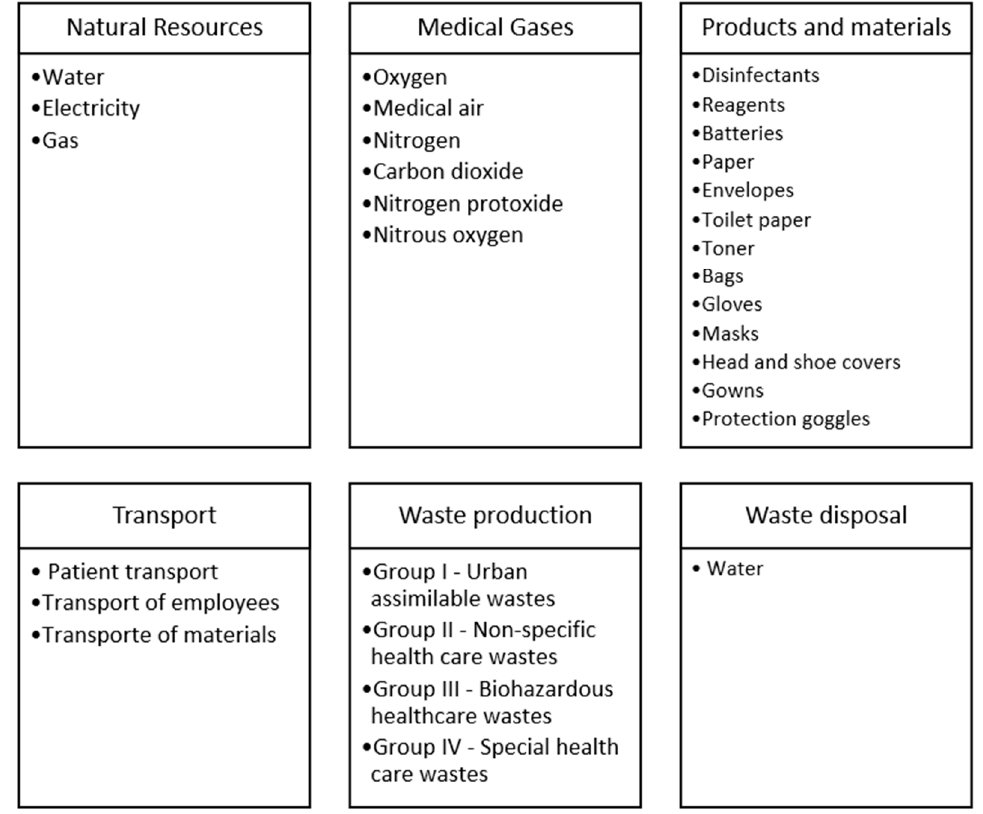
Figure 3. Inputs and outputs included in the environmental index.